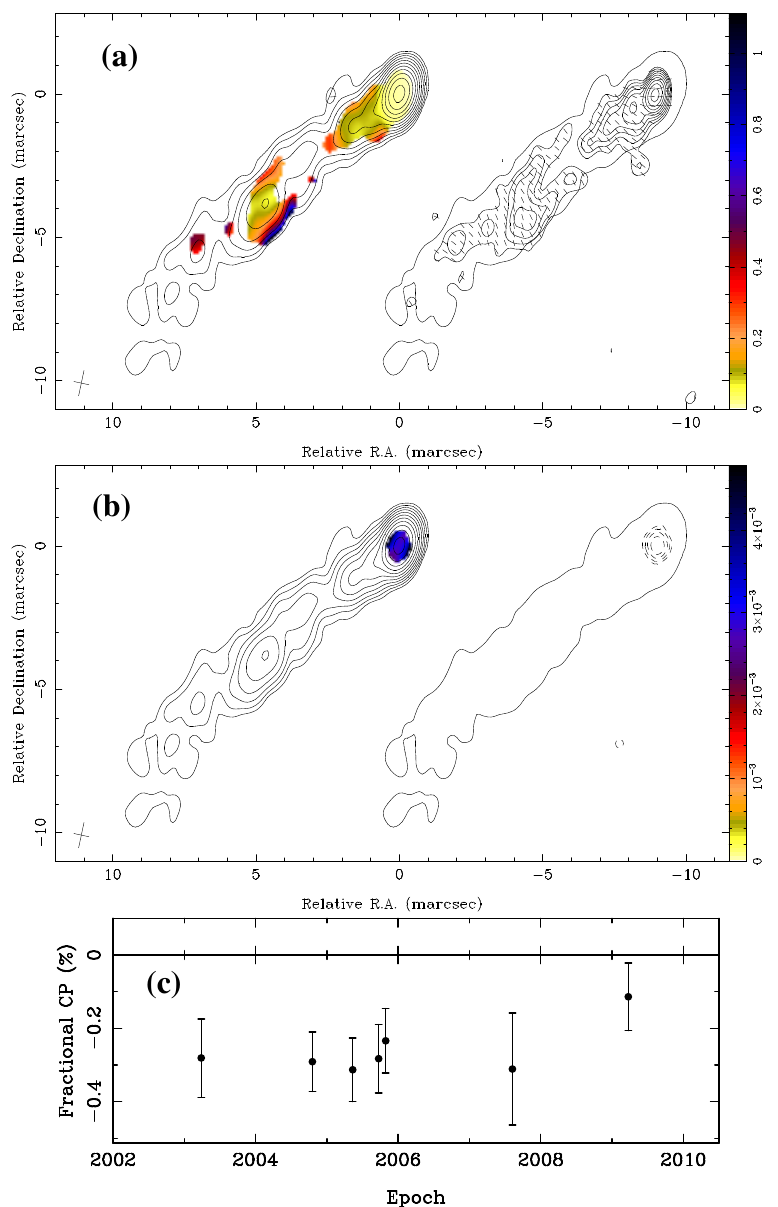
Figure 1. MOJAVE images of the quasar NRAO 140 from 23 September 2005. The left side of panels ( a , b ) show total intensity contours over-plotted with fractional linear and circular polarization colorscale respectively. The high levels of linear polarization, exceeding 70% at the extreme jet edge, are an imaging artifact. The right side of the same panels are contours of the linear and circular polarization, with the tick marks in panel ( a ) representing the electric vector position angle. A single total intensity contour is included to show registration. All contour levels in both panels start at 1 mJy/beam and √ increase in factor of 2 steps. The final panel ( c ) shows the fractional circular polarization of the core as a function of